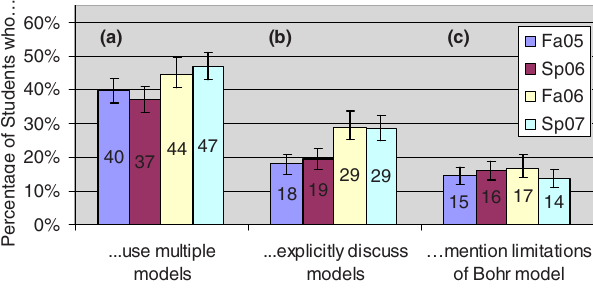
FIG. 3. (cid:1) Color (cid:2) Percentage of students (cid:1) a (cid:2) using multiple mod- els, (cid:1) b (cid:2) explicitly discussing models, and (cid:1) c (cid:2) mentioning limitations of the Bohr model. (cid:1) a (cid:2) includes students who used multiple models both implicitly and explicitly. (cid:1) b (cid:2) includes both students who ex- plicitly referred to models without criticizing them, and students who explicitly discussed the limitations or incorrectness of a model or models. (cid:1) c (cid:2) includes students who mentioned the limitations or incorrectness of the Bohr model or some aspect of it. Error bars represent the standard error on